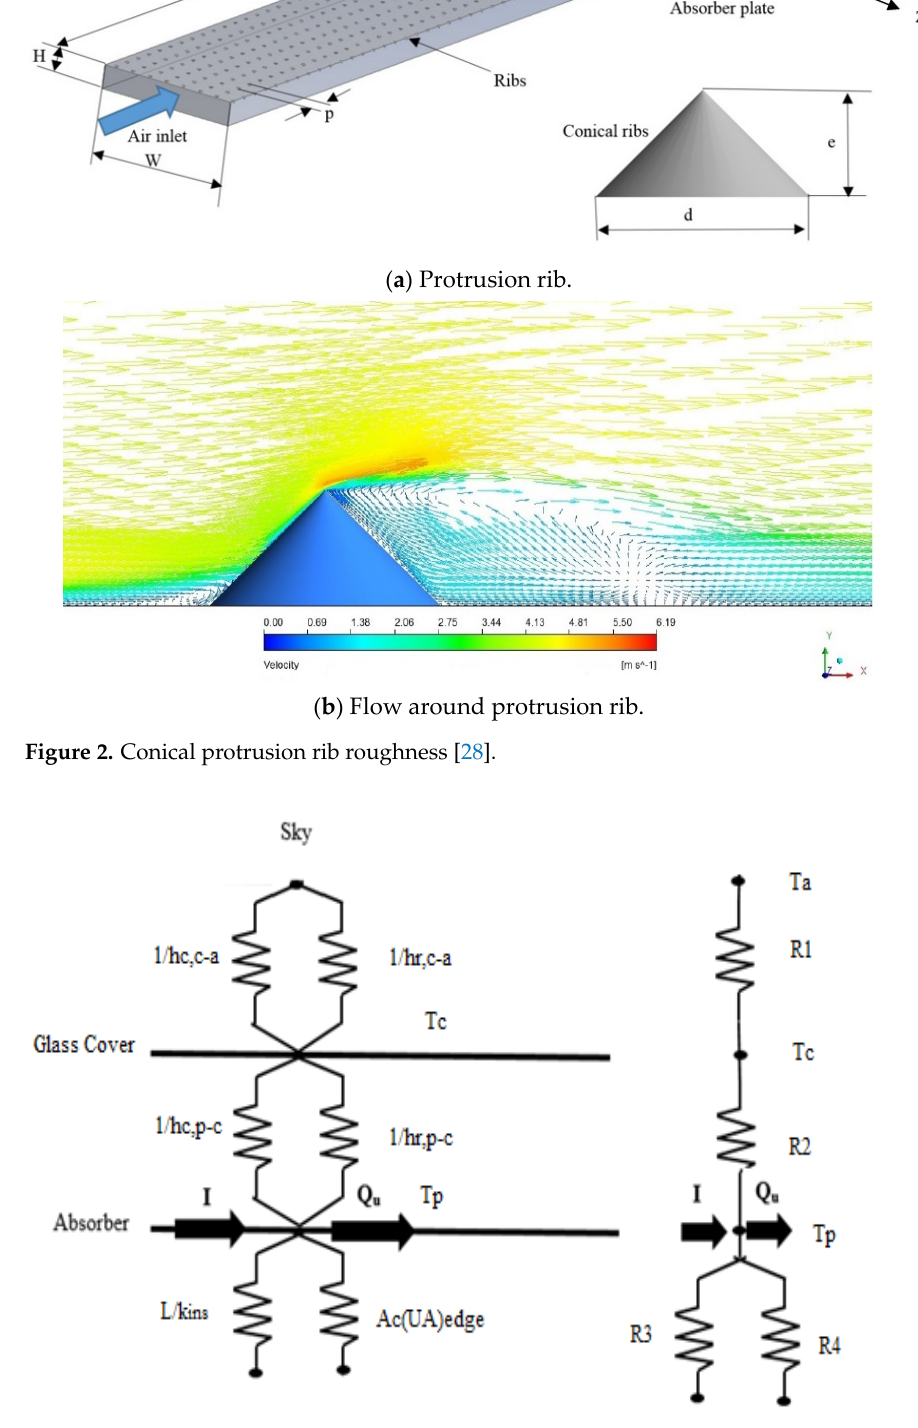
Figure 3. Thermal resistance of an SAH.